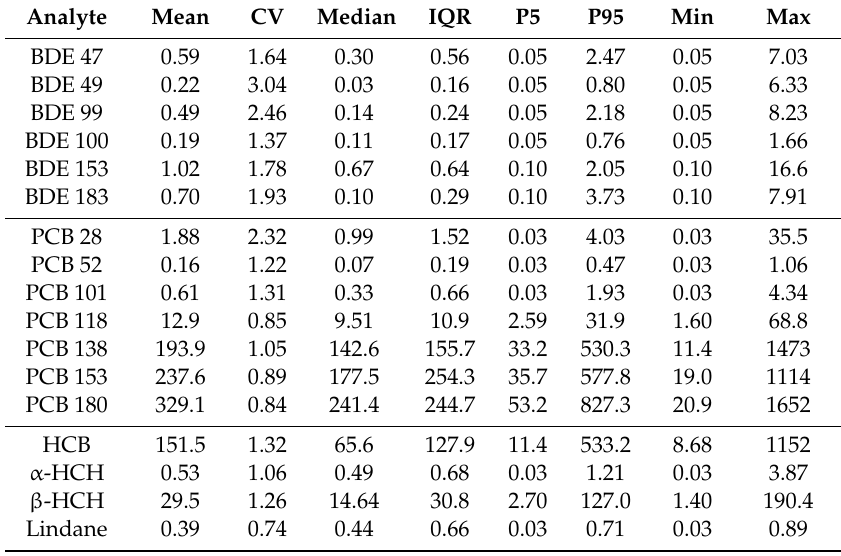
Table 2. Contents of brominated flame retardants and organochlorine pollutants in human adipose tissue (ng / g lipid in adipose